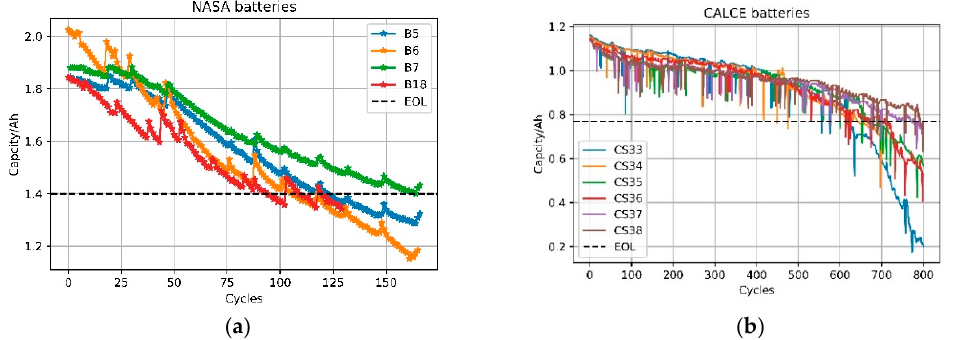
Figure 3. Discharge capacity degradation curves of the two types of batteries: ( a ) NASA batteries; ( b ) CALCE batteries.